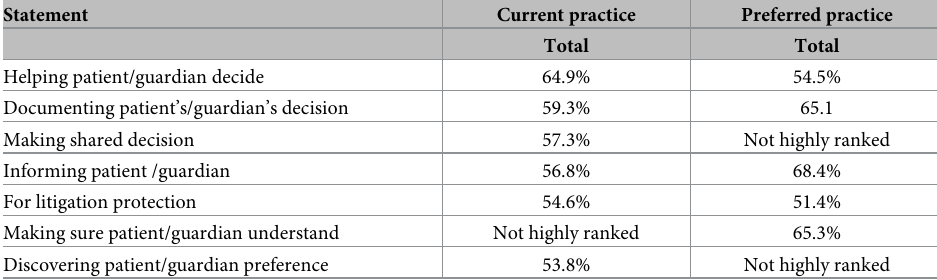
Table 5. Comparison of percentages of high ranked perceived current and preferred patients’ purposes for the IC